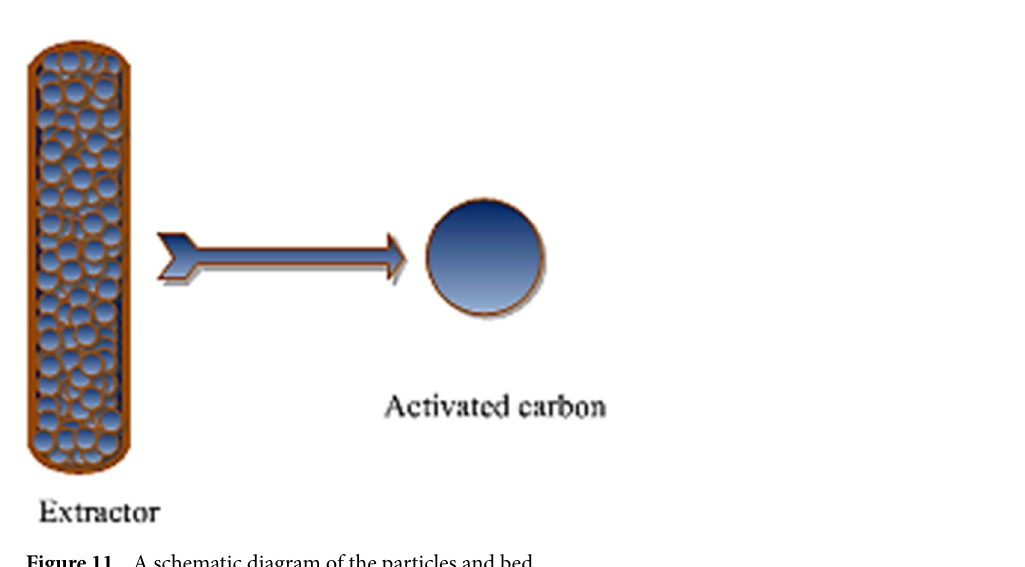
Figure 10. ( a , b ) SEM image of ( a ) un-process, ( b ) process of activated carbon.